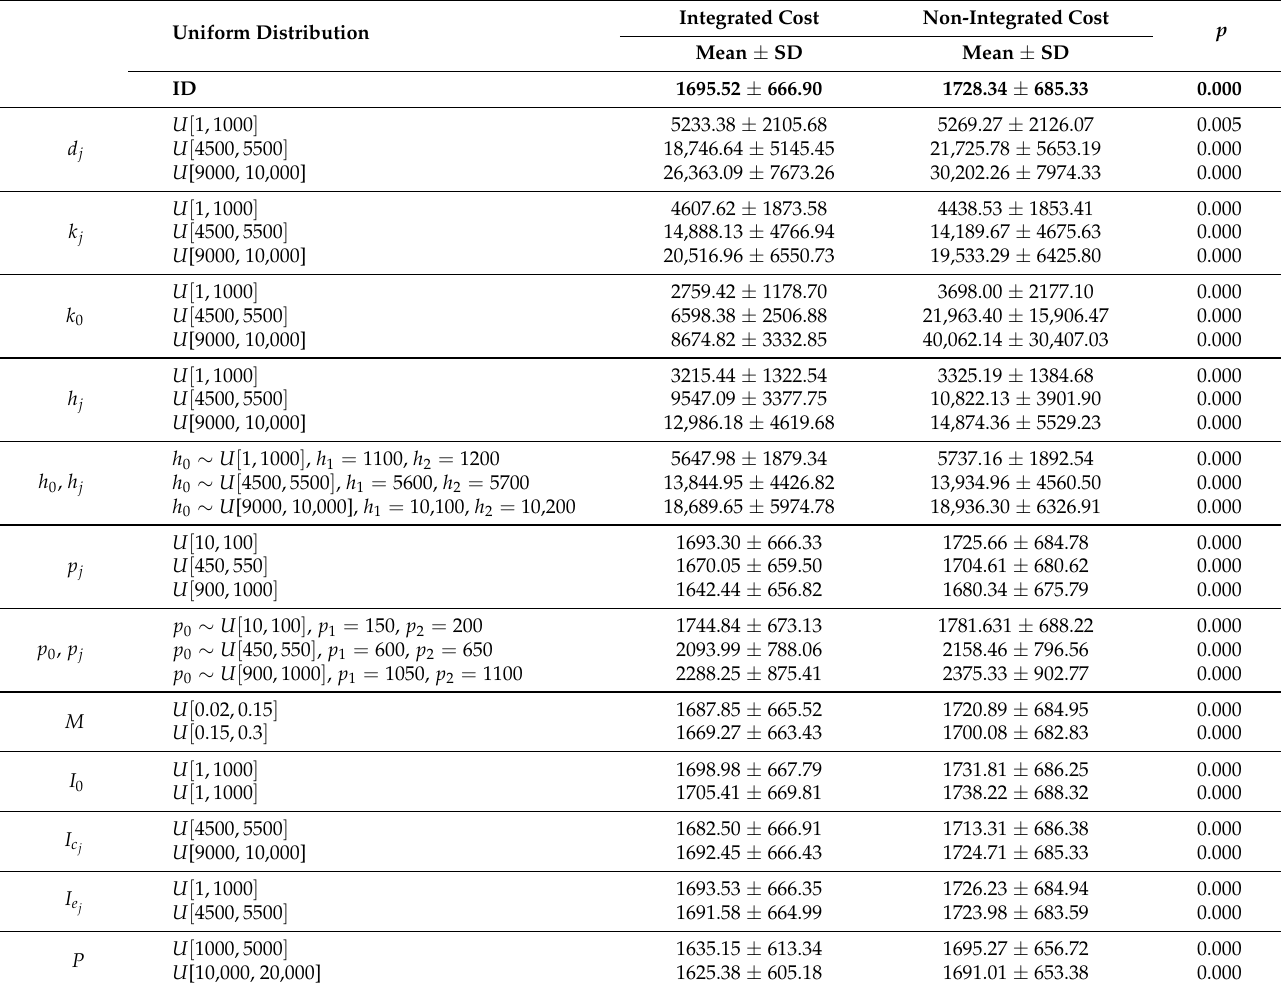
Table 11. The mean values and standard deviations for the integrated and the non-integrated costs for each generated problem set. Significant differences were evaluated by paired t -tests or Wilcoxon